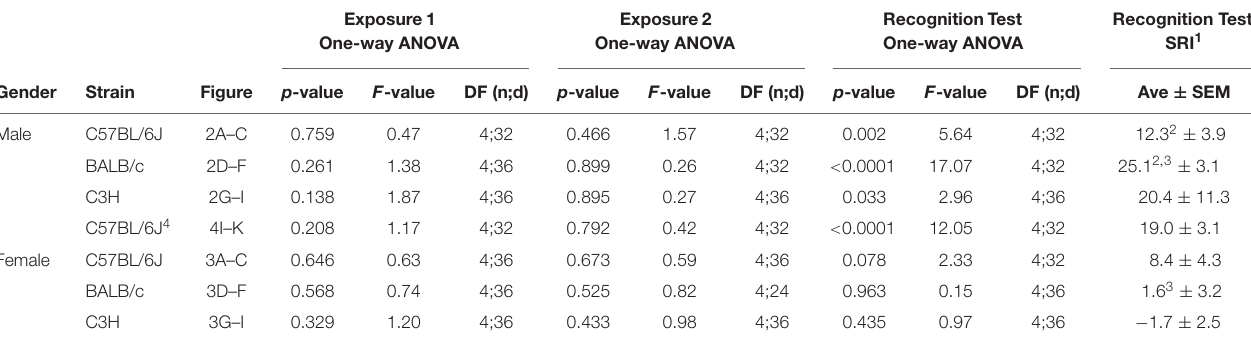
TABLE 2 | Statistical analysis of data presented in Figures